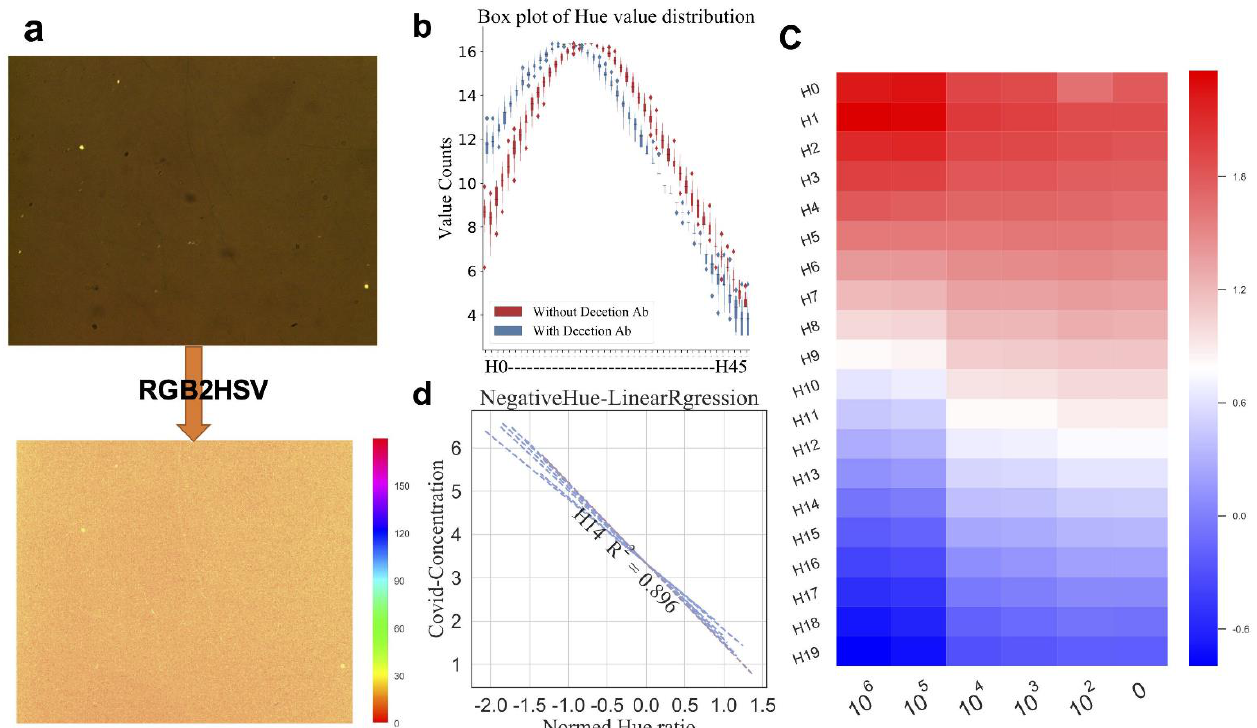
Figure 3. Multiple features related to SARS-CoV-2 virus concentration can be obtained from HSV format images. ( a ) Convert RGB format image of the chip (upper) to HSV format and extract the H channel (bottom). ( b ) The boxplot of frequency of normalized H values of all images of 500 × 500 pixels. Each box represents the distribution of images H frequency. Red box stands for the SP chip, while blue box stands for the 12 min chip (n_500 × 500 = 36) ( c ) Normalized heatmap of ratio values at different degrees of H values in different SARS-CoV-2 concentrations. ( d ) Ordinary linear fitting curves of ratio value at different H degrees with SARS-CoV-2 concentrations; the line represents the fitting curve of a certain H (purple line H14 R 2 = 0.896).